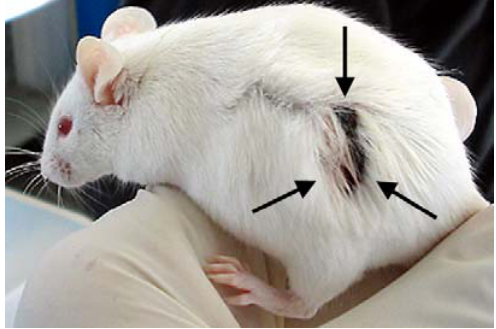
Figure 4: Necrosis at the inoculation site, caused by native bothropic venom, one week after inoculation.